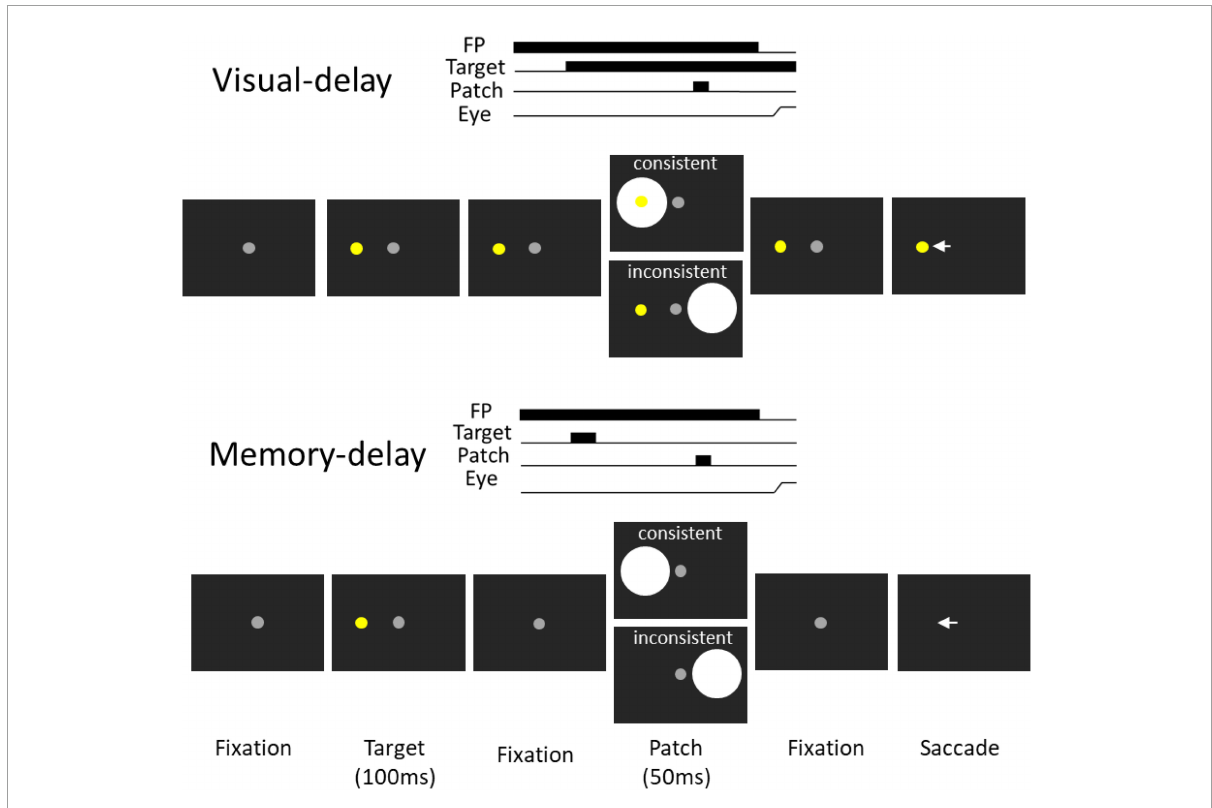
FIGURE1 Experimental paradigm. Each trial started with a central fixation point on a black background. After a delay, there was a presentation of a target stimulus, and after a random delay the central fixation point disappeared and participants were required to move their eyes to the target. During the delay period, a bright circular patch stimulus was presented briefly (50 ms), with the patch being spatially aligned with the target location or the opposite location of the target in the consistent and inconsistent condition, respectively. Memory-delay task was similar to the visual-delay task except the target stimulus was only presented briefly (100 ms). Note that the figure only shows left-target conditions for illustration of the paradigm.